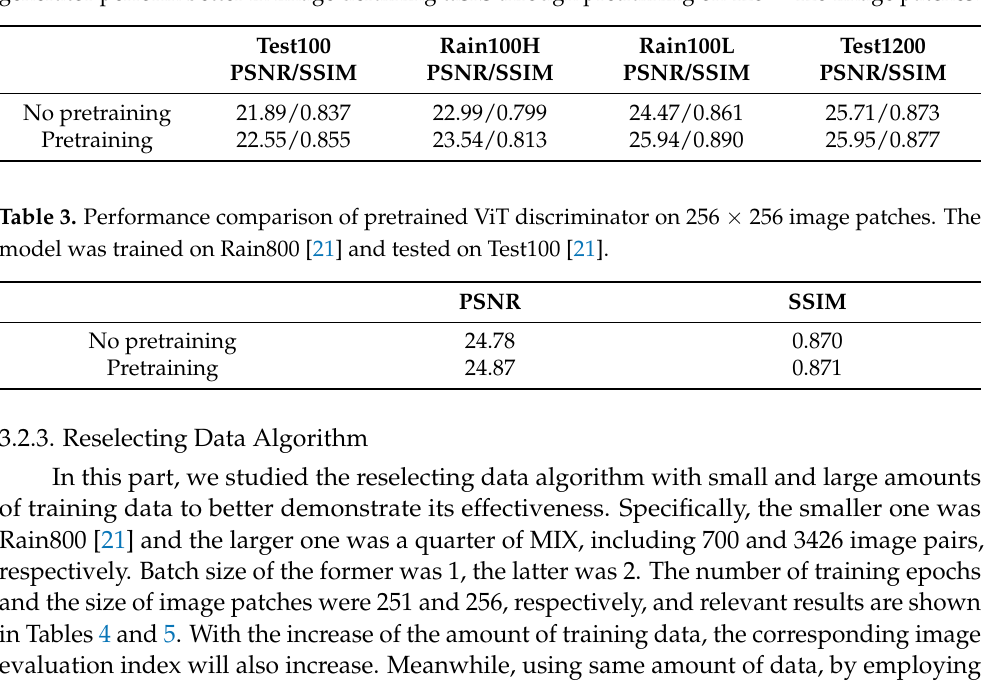
Table 2. Ablation studies on pretraining the discriminator or not. ViT discriminator can make the generator perform better in image deraining tasks through pretraining on 128 × 128 image patches.